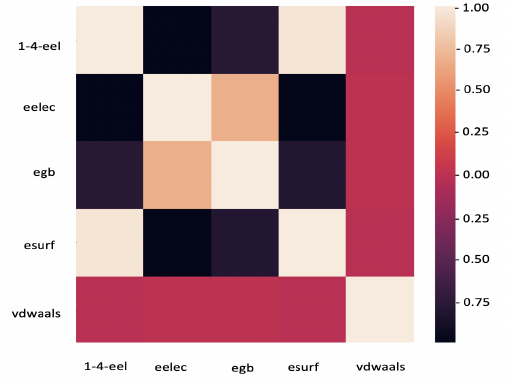
Figure 6. Correlation heatmap between the physics–based features of PDBbind